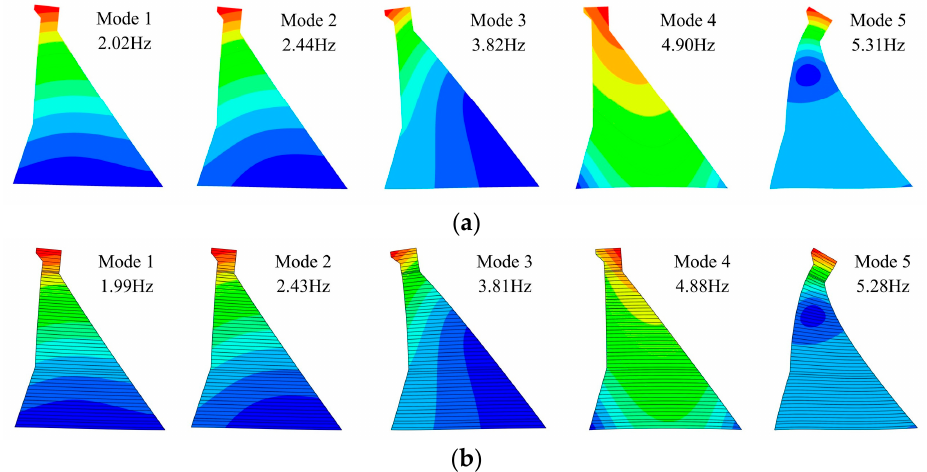
Figure 22. The first five order modes and natural frequencies. ( a ) Without RCC layers; ( b ) with RCC layers.